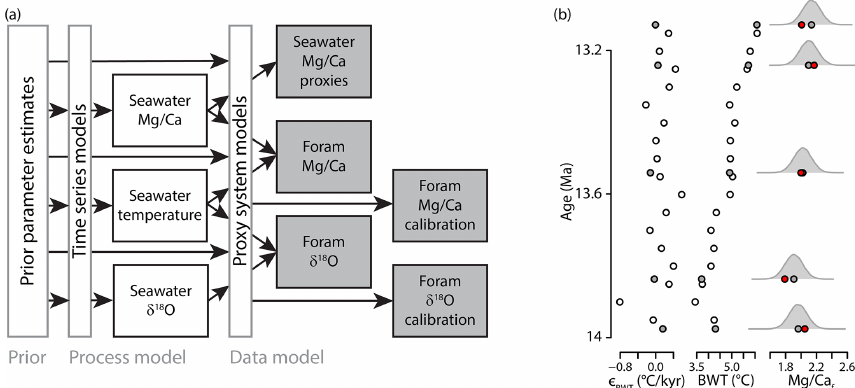
Figure 1. Implementation of JPI for the coupled Mg / Ca and δ 18 O proxy systems. (a) A schematic is shown. Gray-outlined boxes and text represent the three components of the Bayesian hierarchical model. Markov Chain Monte Carlo sampling is used to “explore” the prior parameter space and develop a statistically representative posterior sample of the parameters and paleoenvironmental time series that are consistent with all paleo-proxy and proxy calibration data (gray-filled boxes). (b) Example showing a subset from a single member of the site 690 posterior distribution. Error term values ( (cid:15) BWT ) dictate the simulated paleoenvironmental time series trend (in this case BWT) modeled at a base frequency (white fill) and all proxy sample levels (gray fill). The environmental state and proxy model parameter values from the posterior sample are used to model the predicted proxy signal (here Mg / Ca f ; means as gray filled circles and probability density functions as curves). The likelihood of the posterior sample is evaluated based on the probability of the observed proxy data (here foraminiferal Mg / Ca, red circles) given the modeled